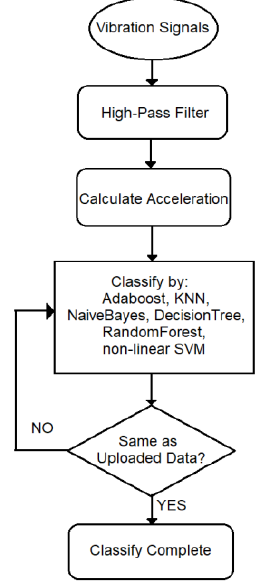
Figure 3. Machine status classification flowchart.